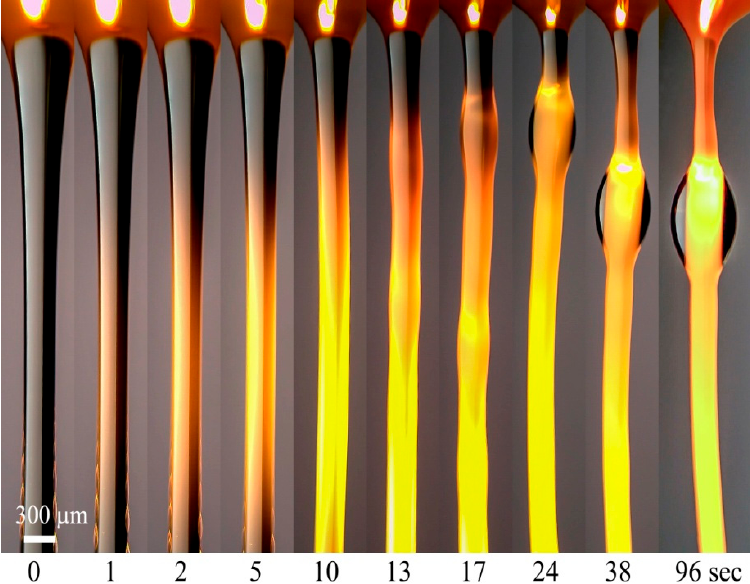
Figure 16. Phase separation at a constant draw ratio of PAN solution jet occurring in time (according to